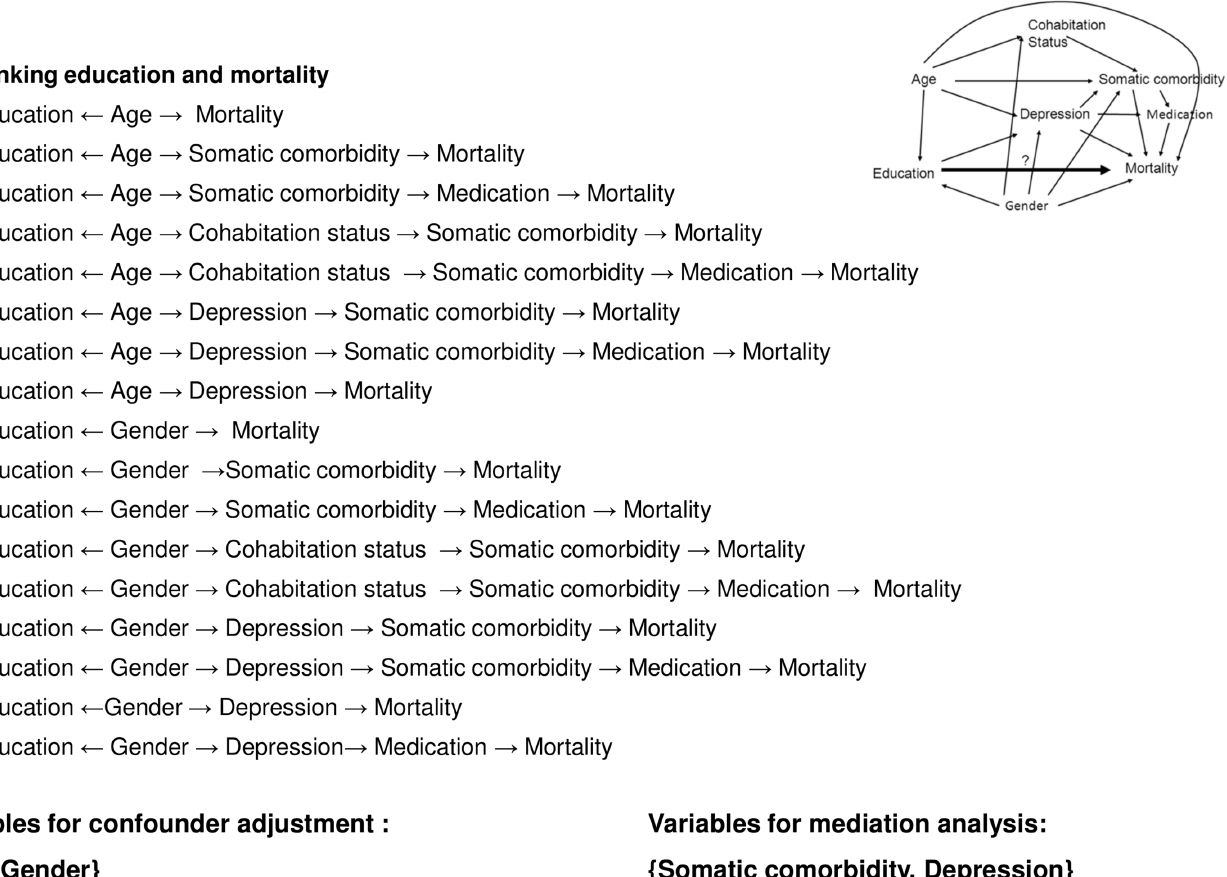
Fig 1. Directed acyclic graph of the assumed relationship between education and mortality with paths used for identifying potential confounding and mediating factors.